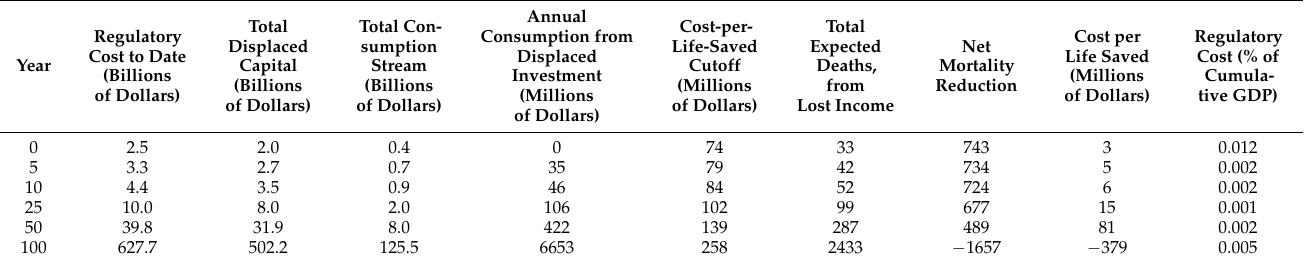
Table 2. Mortality Risk over a Century Owing to OSHA’s Occupational Exposure to COVID-19 Emergency Temporary